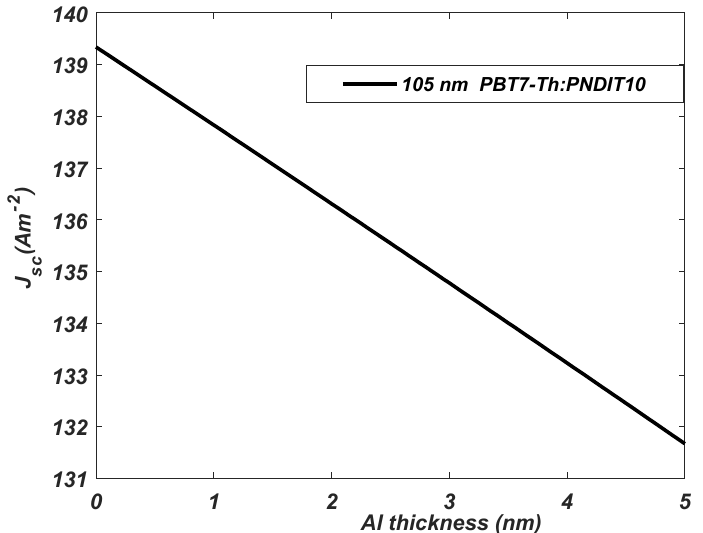
Figure 4. J SC plotted as a function of the Al film thicknesses up to 5 nm in the inverted OSC by keeping the thickness of the active layer at 105 nm.